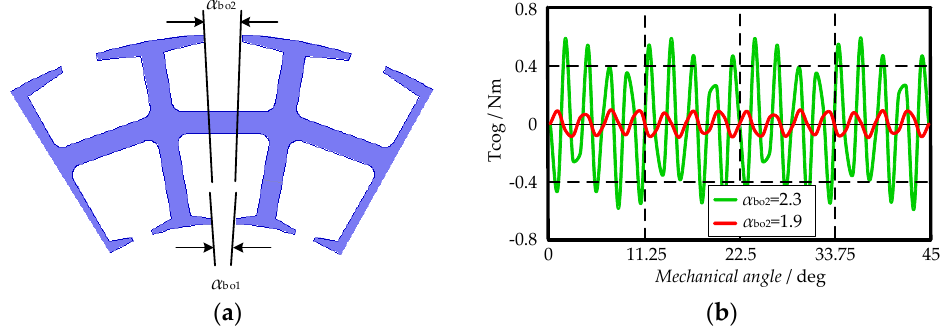
Figure 17. ( a ) Different slot opening angular α bo2 < α bo1 ; ( b ) Comparison of cogging torques for different slot opening angular α bo2 .